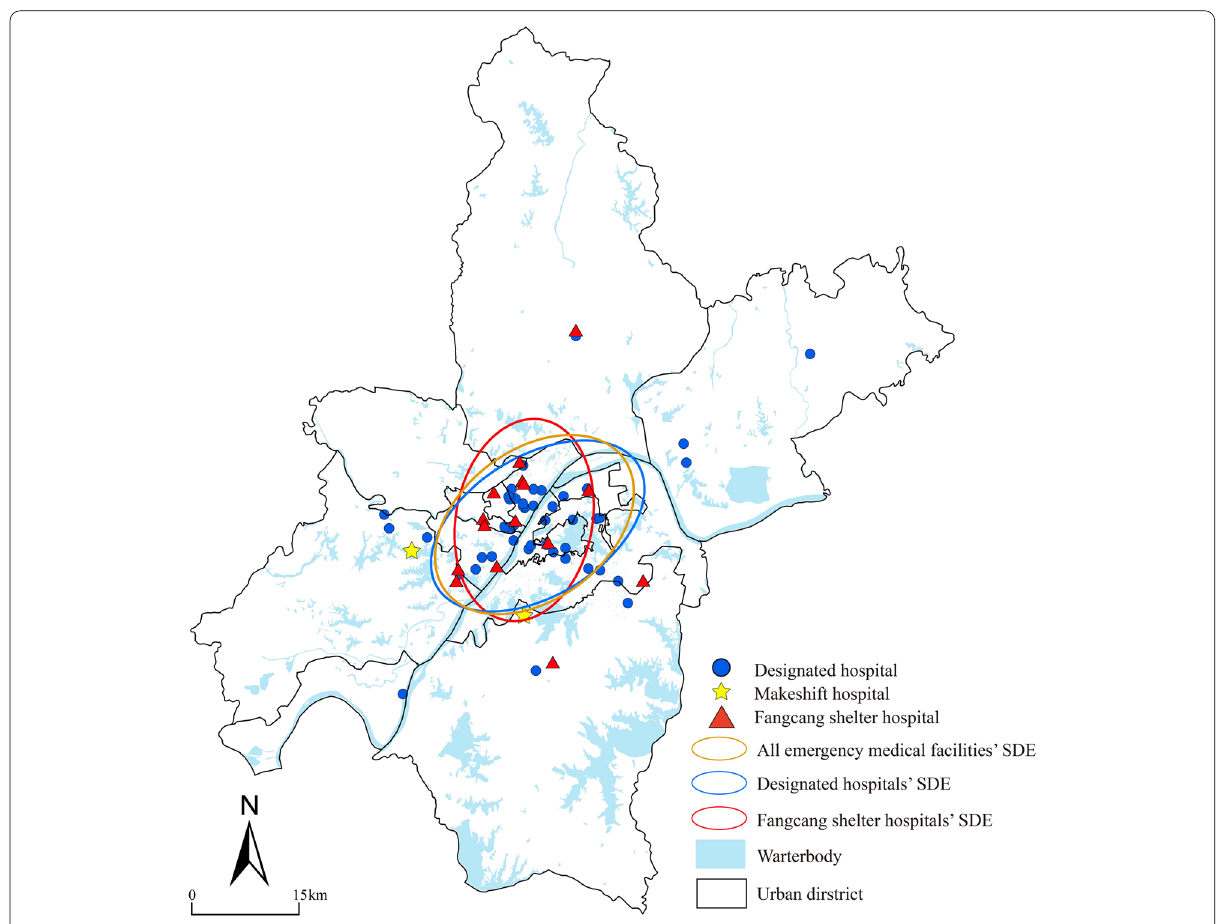
Fig. 4 The Layout of Emergency Medical Facilities in